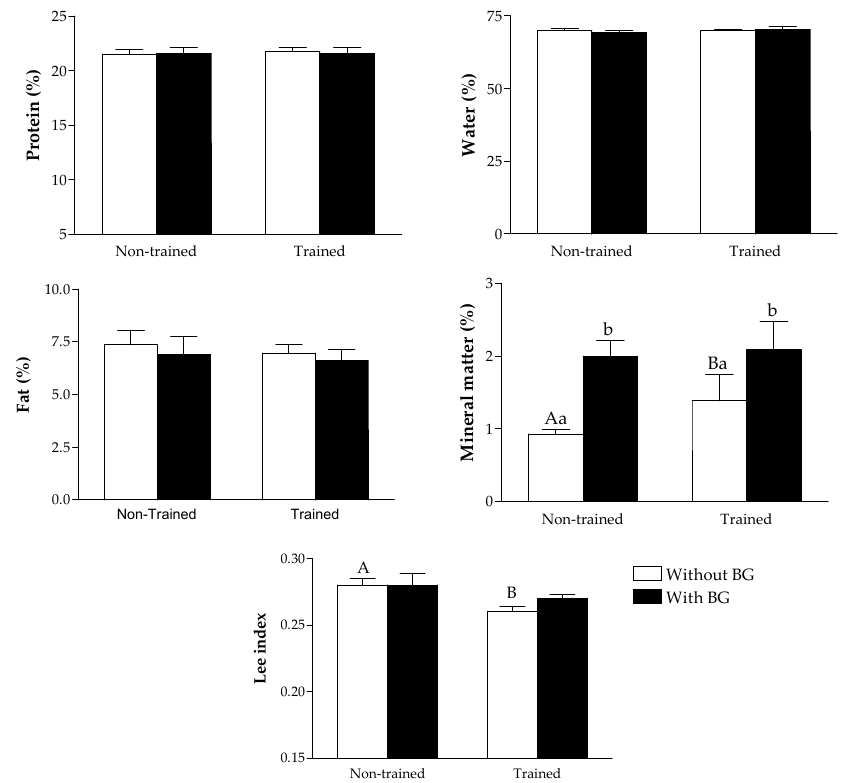
Figure 1. Chemical body composition (water, protein, fat and mineral matter) and Lee index of type 2 diabetic rats (high ‐ fat diet/streptozotocin) submitted to physical training and treated with beta ‐ glucan (30 mg/kg/day). A,B Significant difference between trained and non ‐ trained groups; a,b Significant difference between groups with and without beta ‐ glucans.